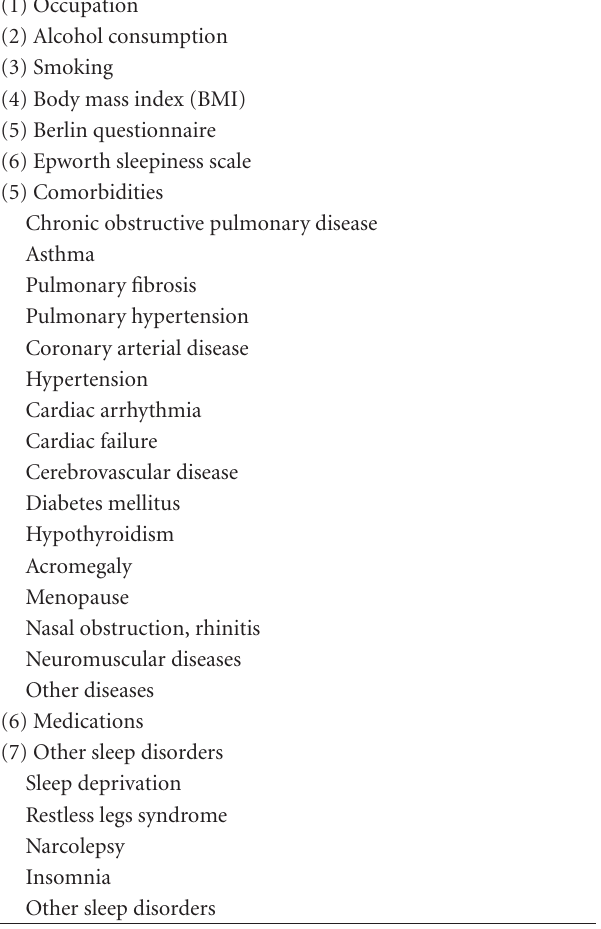
Table 1: Clinical